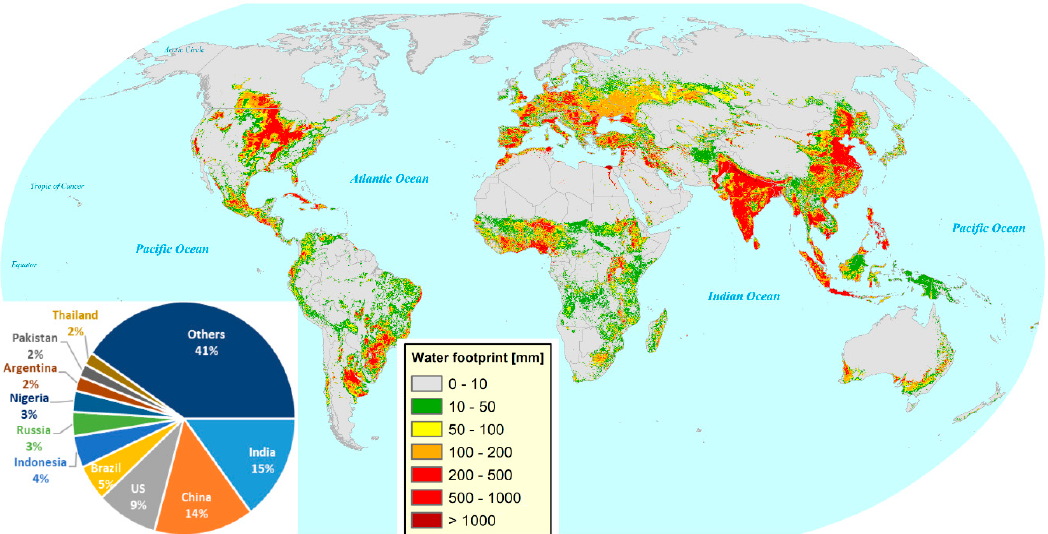
Figure 1. The total (green, blue, and grey) WF of food crops production. The WF of fiber crops, rubber, tobacco, and fodder crops is excluded. The pie chart shows the contribution of countries to total WF. Data source from Mekonnen and Hoekstra [29].